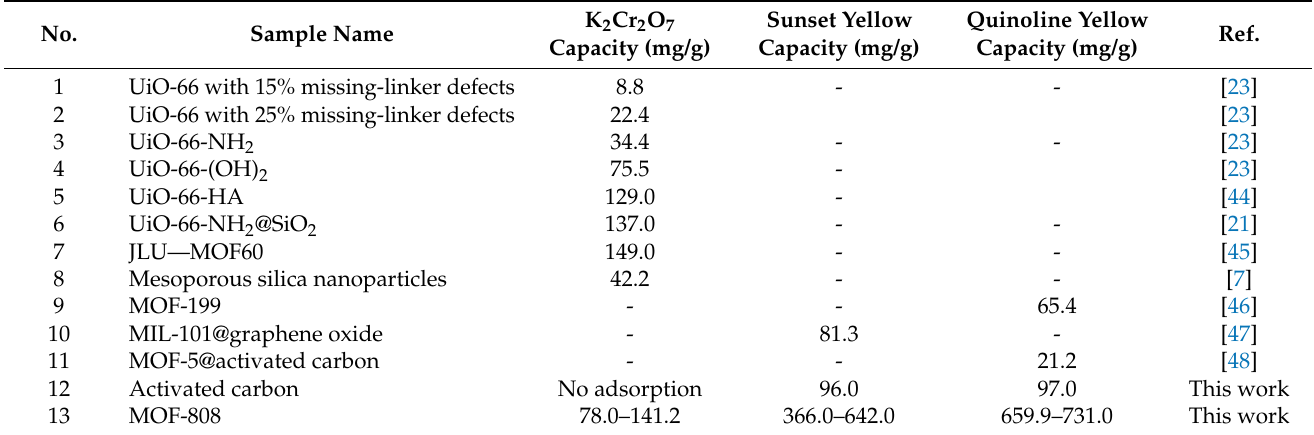
Table 3. Comparison of the anion trapping capacity of MOF-808 with various materials reported from the literature.